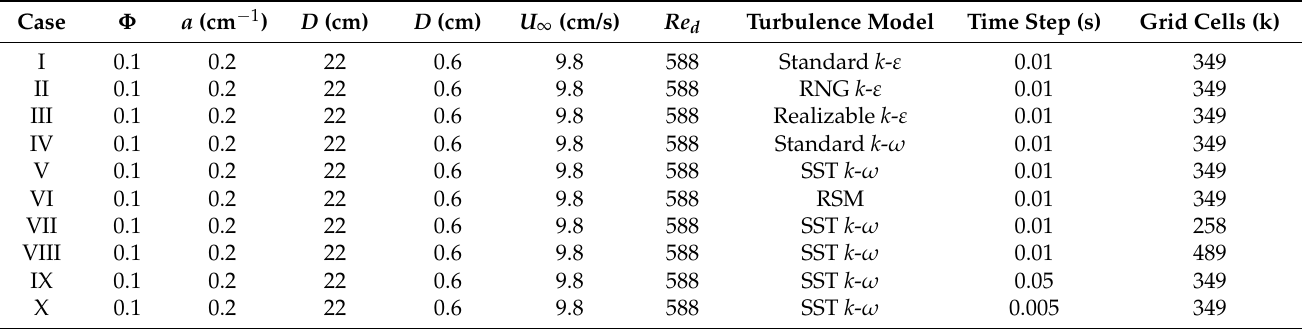
Table 1. Information of numerical simulation cases. Geometric and hydrodynamic parameters are given.